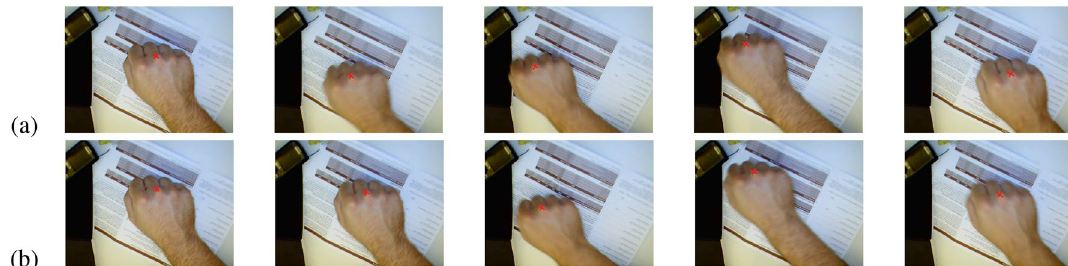
Figure 7. Cross. ( a ) Traditional clustering algorithms, ( b ) our clustering